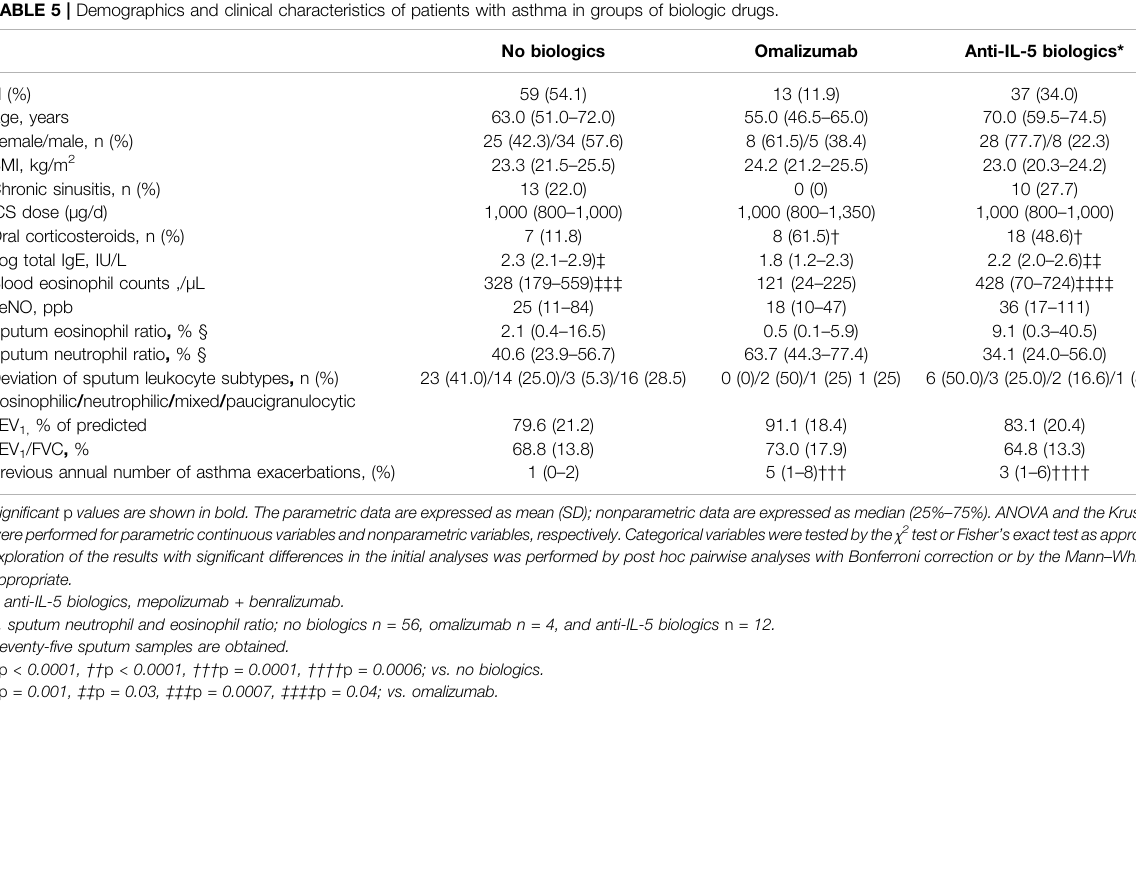
TABLE 5 | Demographics and clinical characteristics of patients with asthma in groups of biologic drugs.